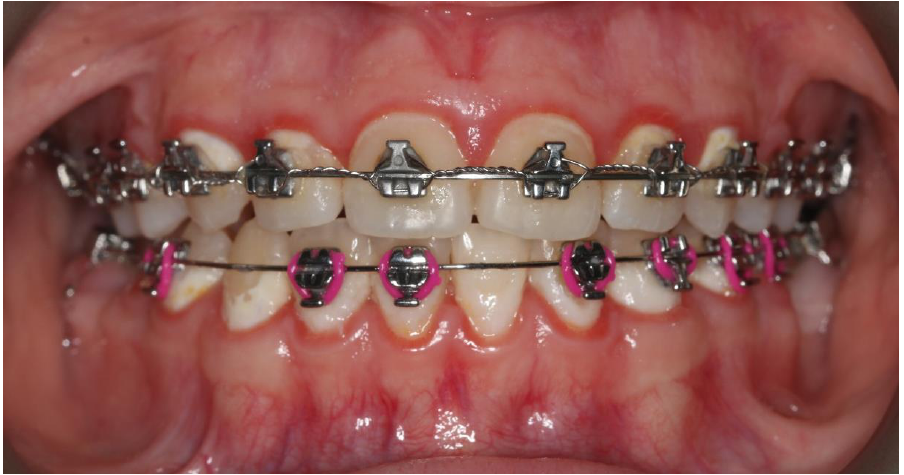
Figure 2. Gingivitis associated with dental plaque.